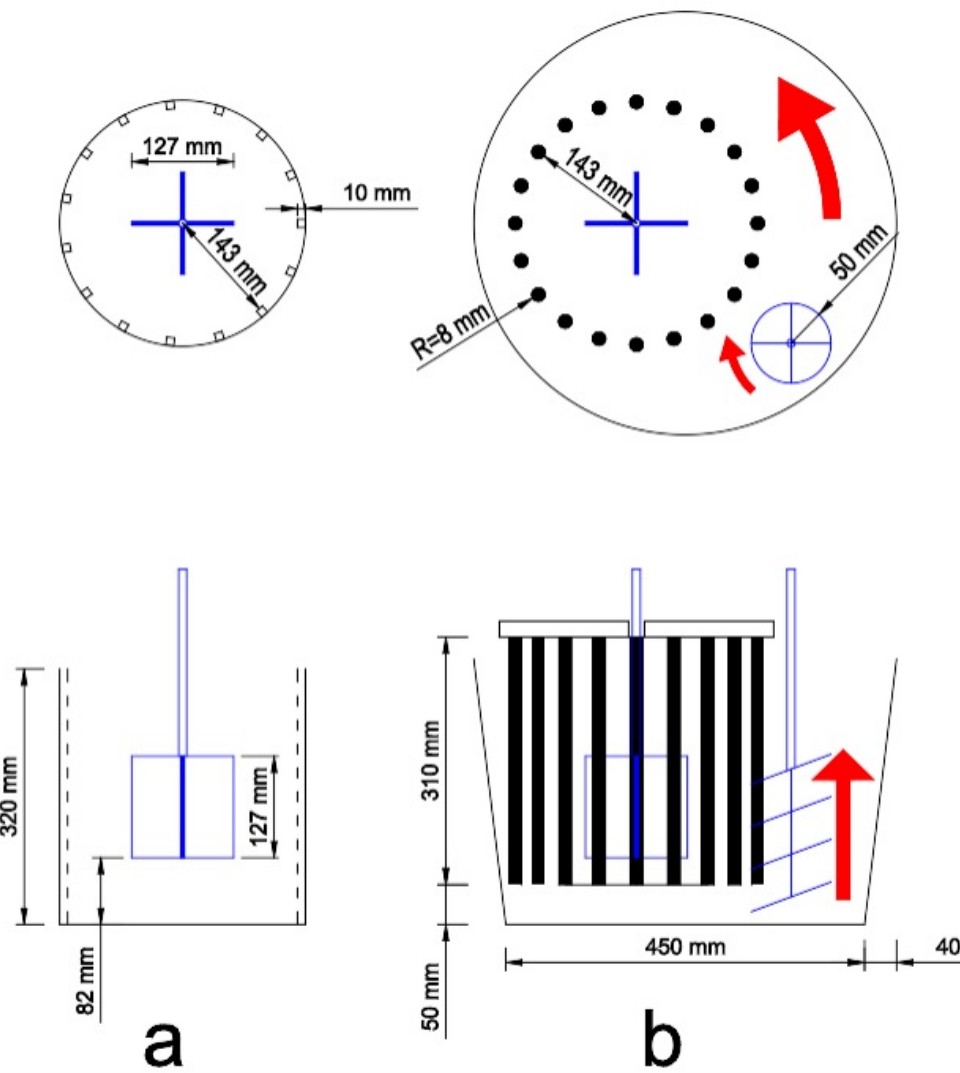
Figure 1. ( a ) Schematic diagram of the ICAR rheometer with the blade agitator in a container. ( b ) Schematic diagram of the experimental setup with rotating bucket and the whisk for the ICAR rheometer.